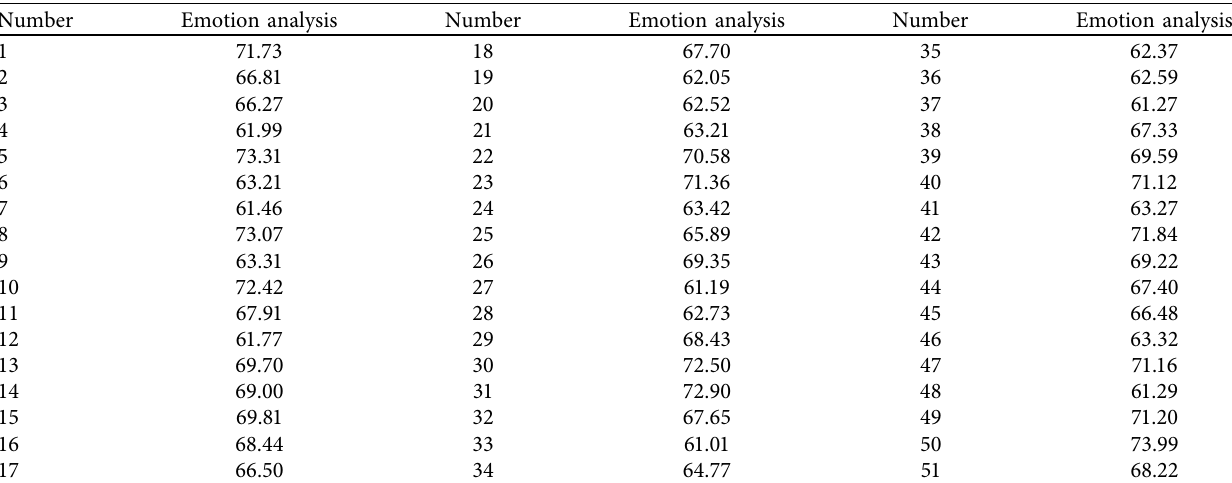
Table 2: The music sentiment analysis effect of the music audio analysis model based on spectrum analysis technology. Number Emotion